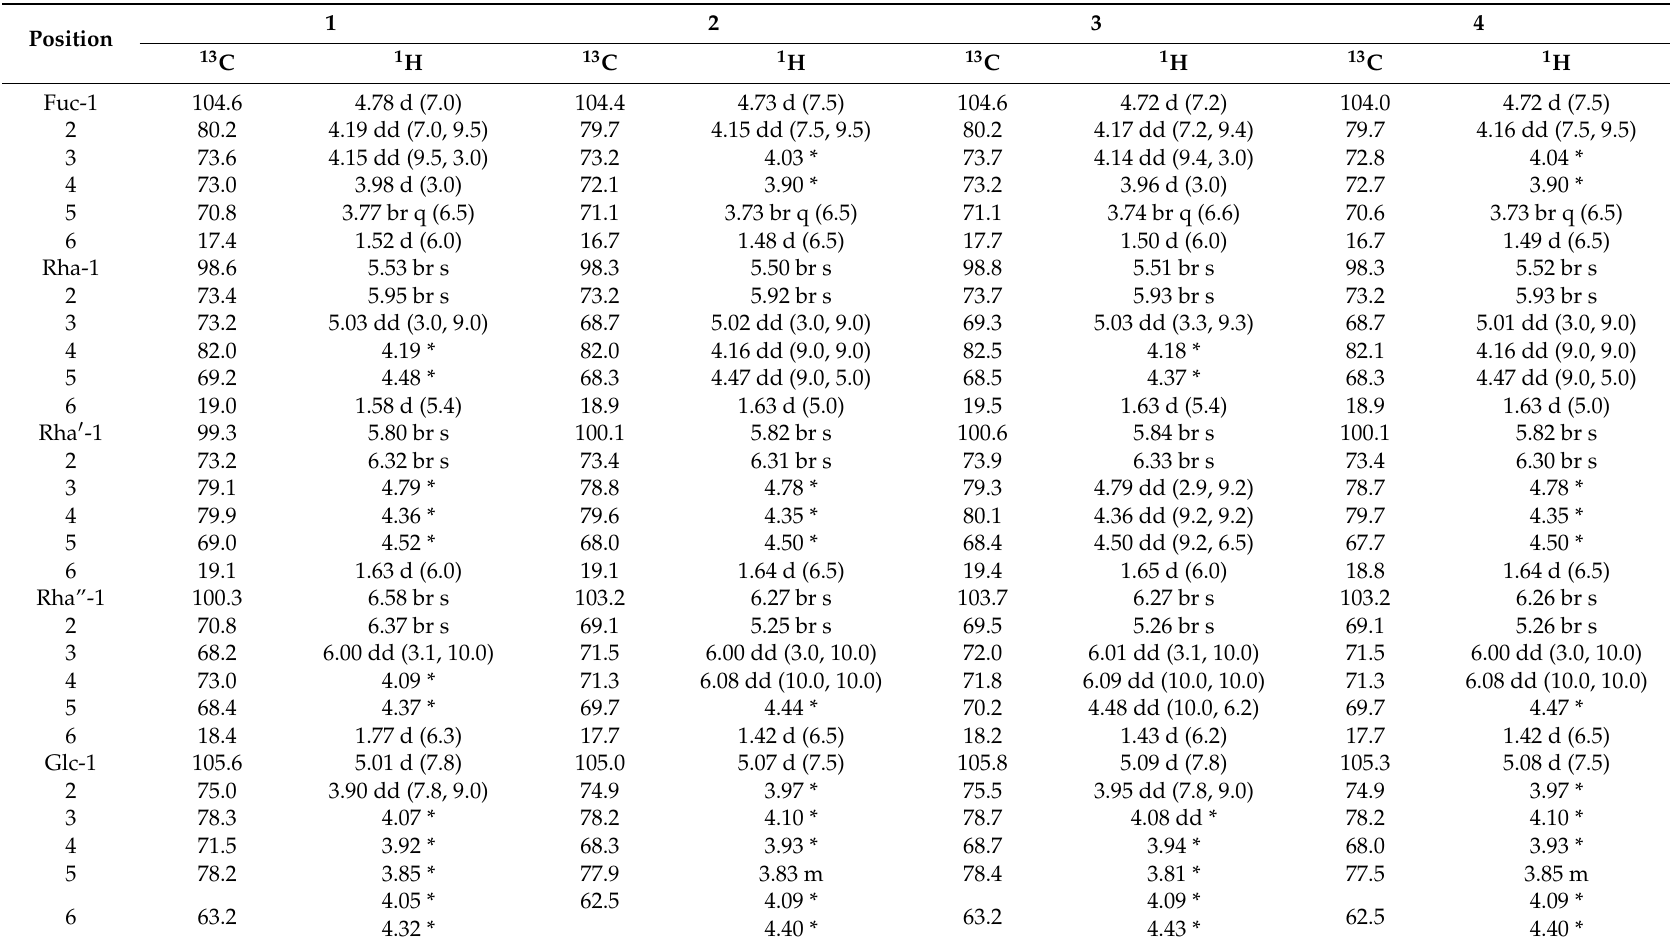
Table 1. NMR data for compounds 1 – 4 in pyridine- d 5